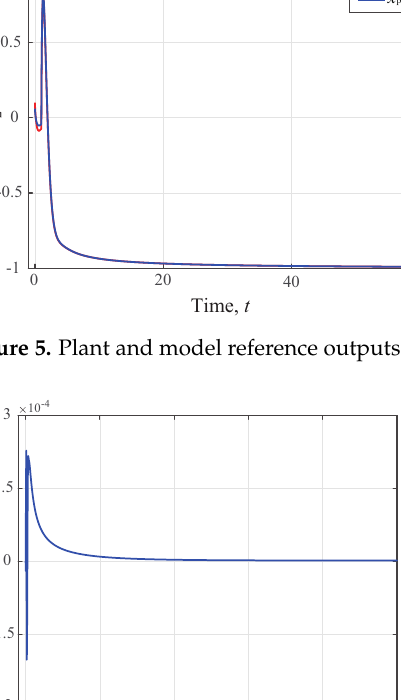
Figure 6. Scalar function ϕ ( t )